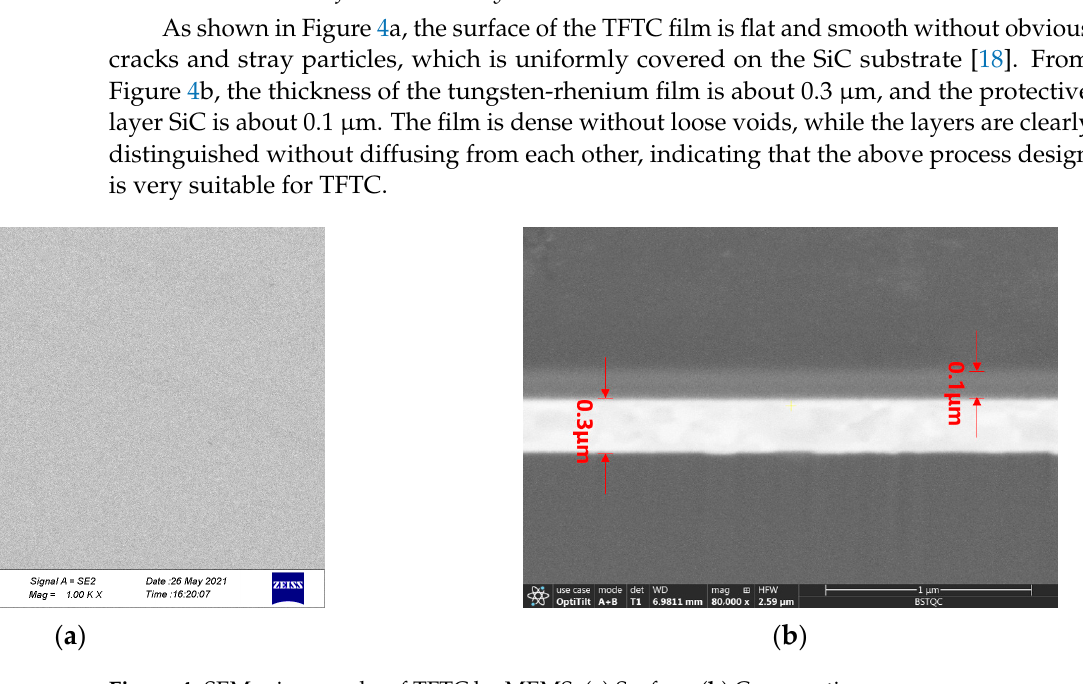
Figure 4. SEM micrographs of TFTC by MEMS. ( a ) Surface; ( b ) Cross section.